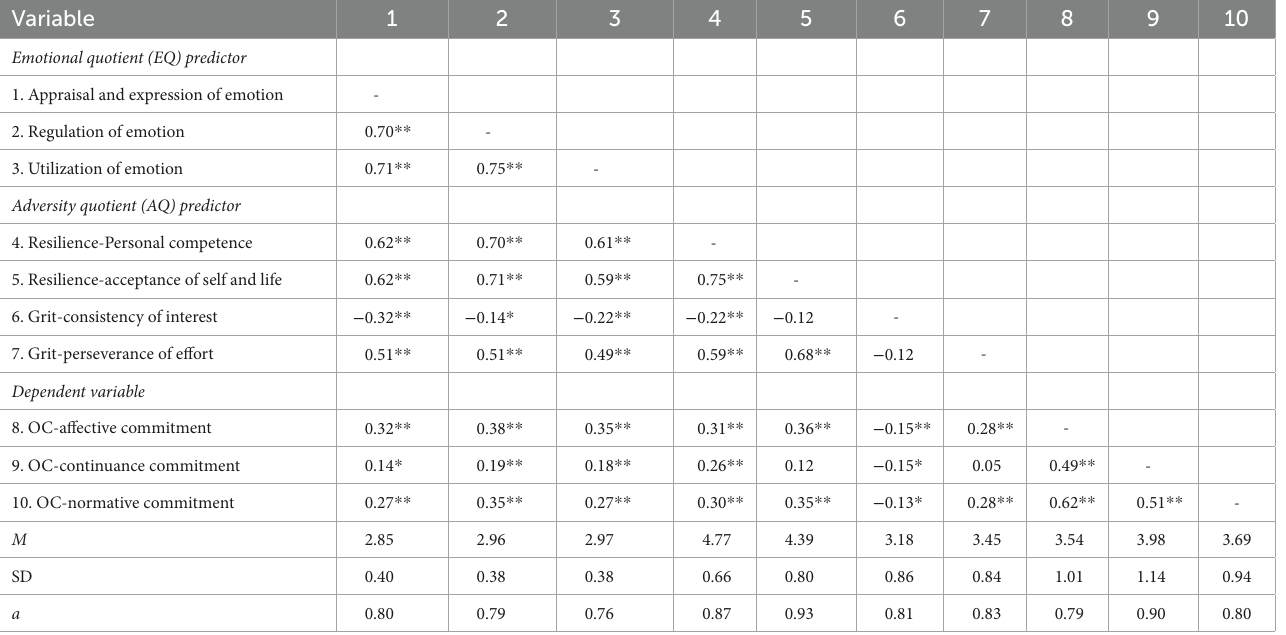
TABLE 2 Descriptive statistics and correlations between study variables.